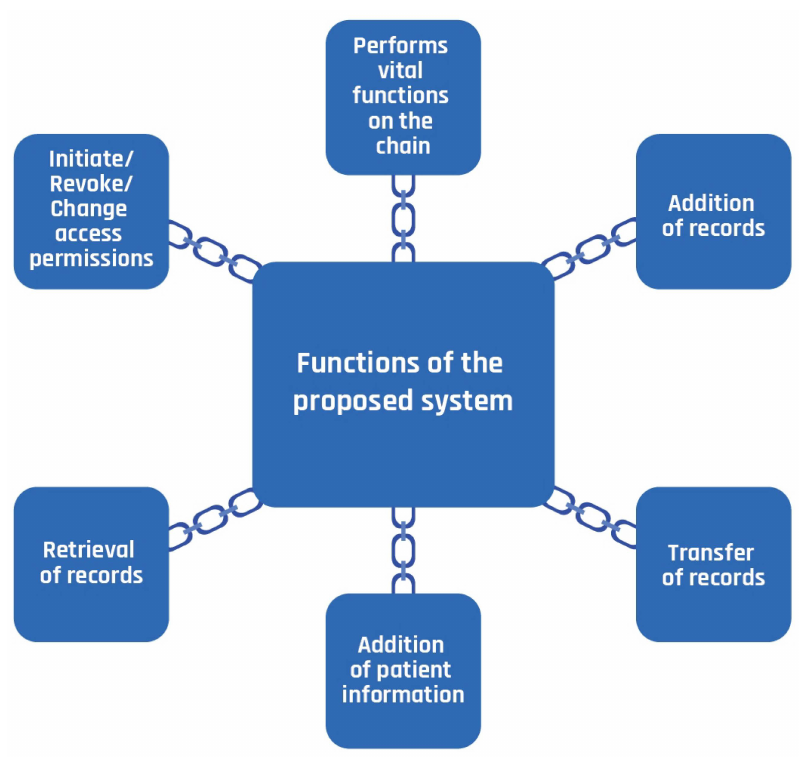
Figure 5. Functions that can be carried out by the proposed system